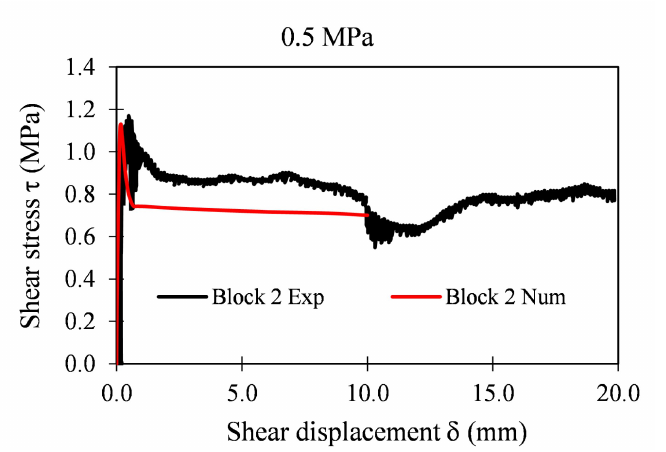
Figure 25. Shear stress evolution with displacement Exp–Num (Block 2).